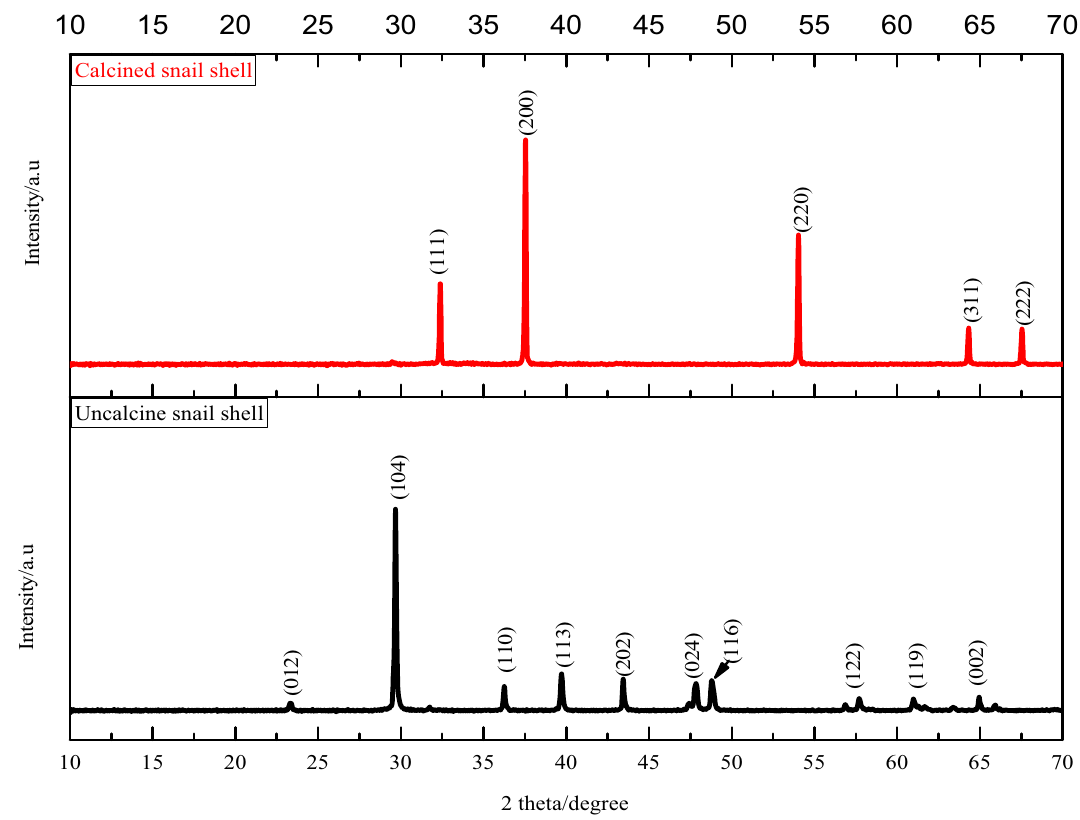
Fig. 2 XRD analysis of raw snail shells and calcined snail